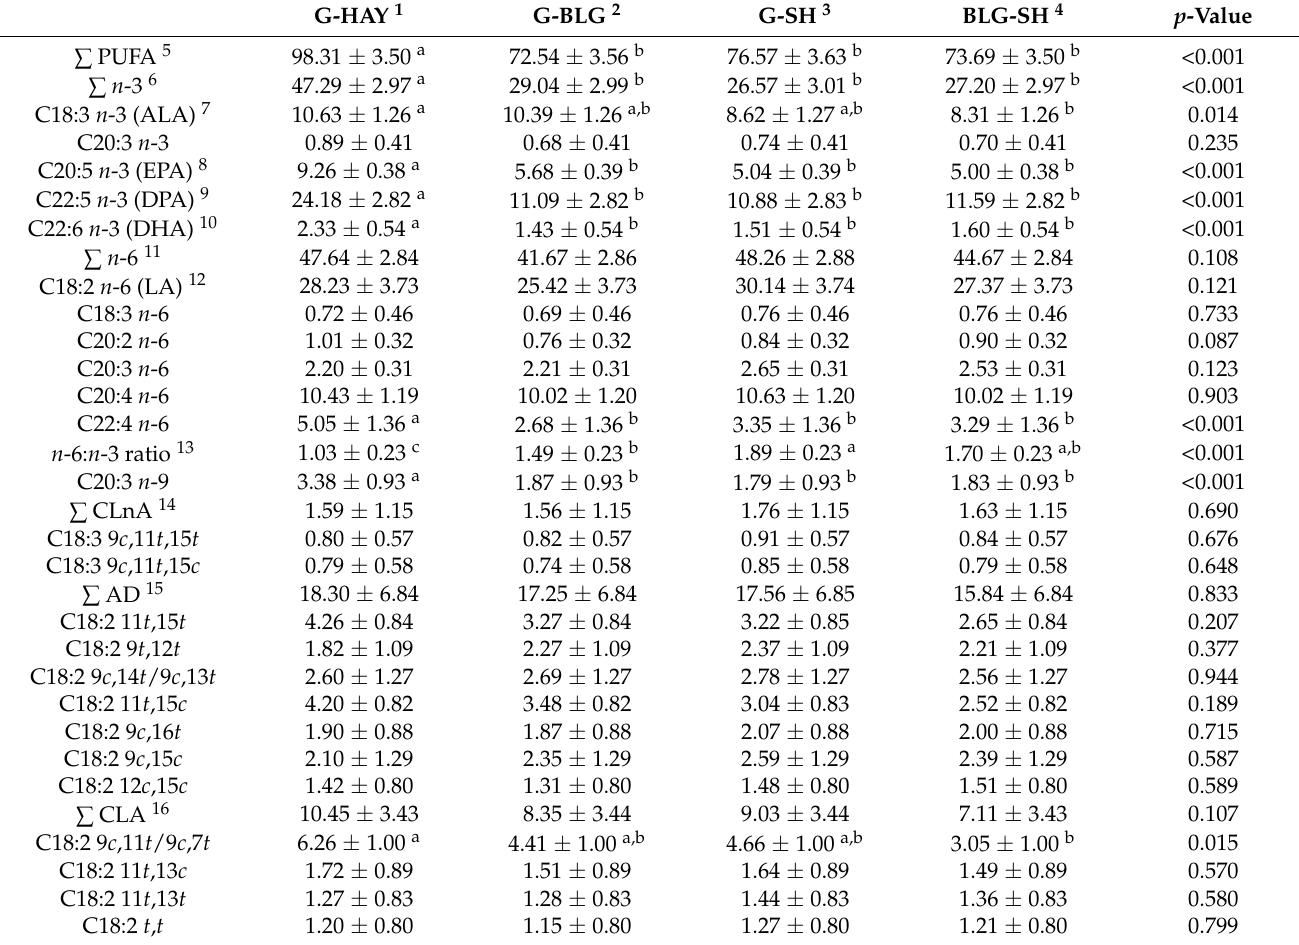
Table 5. Mean concentration of polyunsaturated fatty acids by diet (mg per 100 g beef).